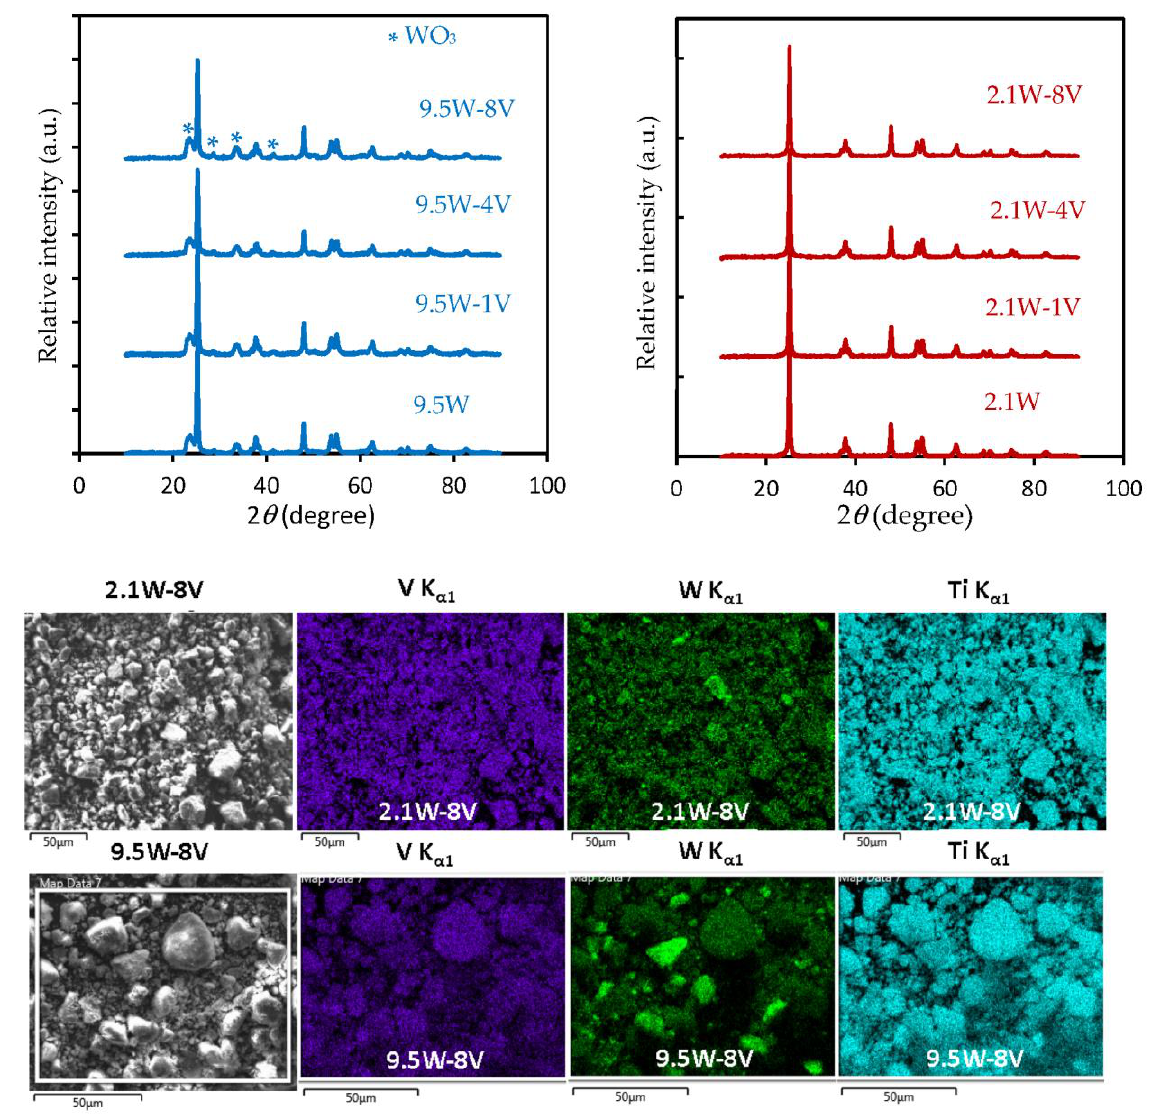
Figure 5. XRD and EDS analyses on freshly prepared V 2 O 5 - WO 3 /TiO 2 catalysts calcined in air at 450